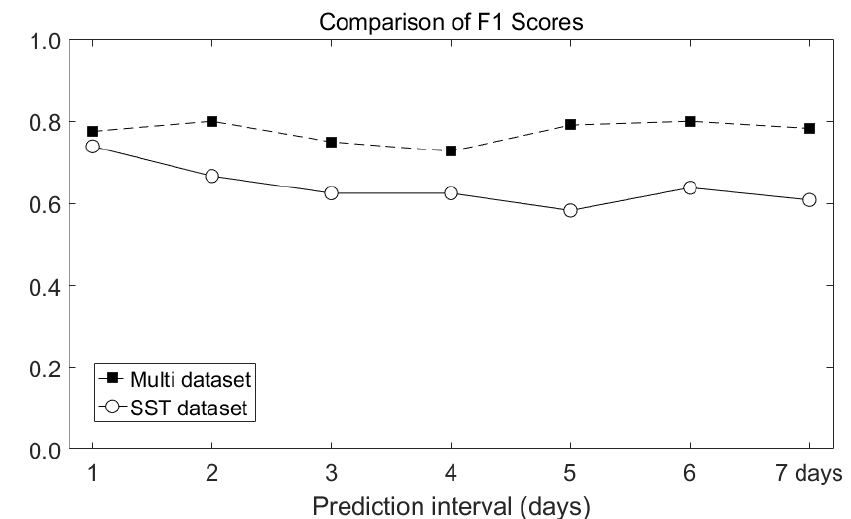
Figure 13. Comparison of F1 scores obtained using the two input datasets.